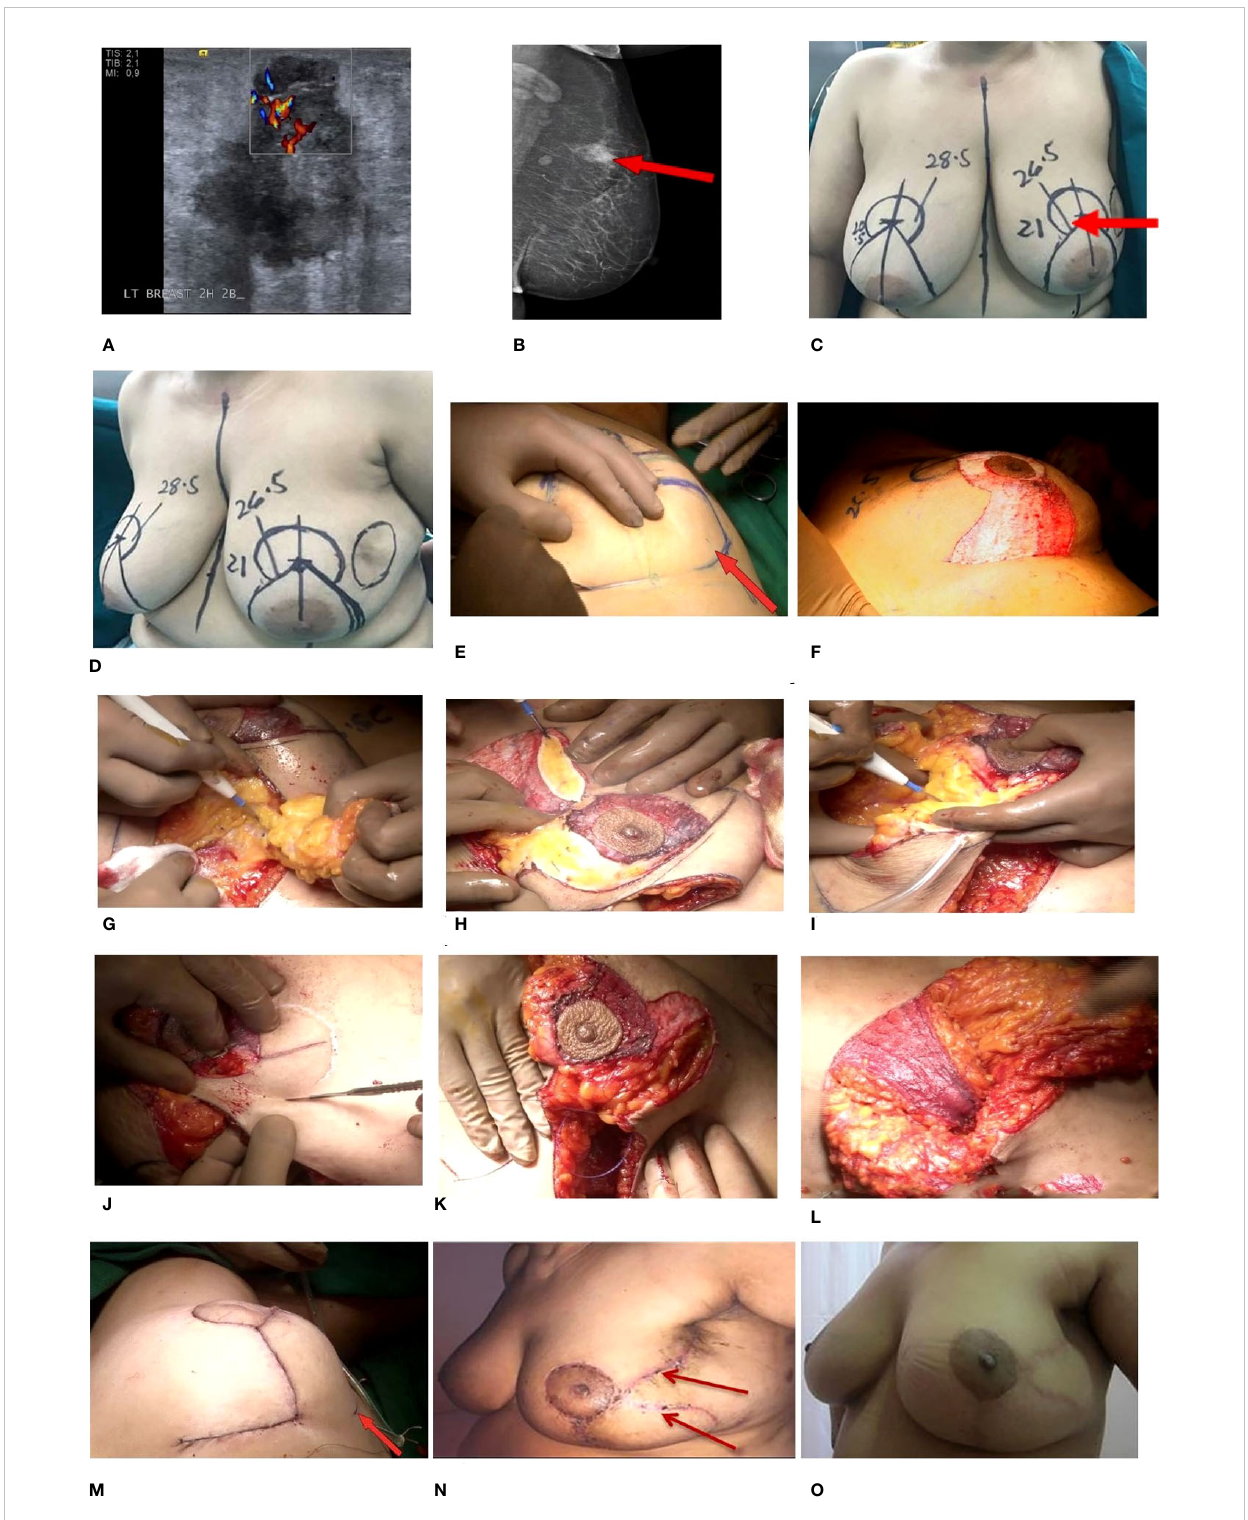
FIGURE 8 Split reduction TM. (A, B) Pre-operative radiology images. (A) 2D mammogram — MLO view of the left breast. Oval iso- to hyperdense lesion is seen in the upper quadrant of the left breast, which shows spiculations and a small enlarged left axillary node. (B) USG — a hypoechoic solid lesion, taller than wide is seen at the 2 o ’ clock 2B position of the left breast. (C, D) Markings also showing tumor in the UOQ with involved skin (arrow). (E – M) Intra- operative images. (E) No incision on lower outer part of IMF. (F) De-epithelialized inferior pedicle along with the medial wing. (G) Excision of the tumor along skin. (H) Dual pedicles being de fi ned. (I) Delineating the superomedial pedicle. (J) Marking of the future NAC. (K) Connecting the tumor cavity and the lateral wing to create a continuum of skin. (L) Inferior pedicle being used as a fi ller. (M) Restructured breast, with the dermal incision in the lateral aspect taken inadvertently. Post-operative images at (N) 1-month follow-up and (O) 3-year follow-up. TM, therapeutic mammoplasty; MLO, mediolateral oblique; USG, ultrasonography; UOQ, upper outer quadrant; NAC, nipple – areolar